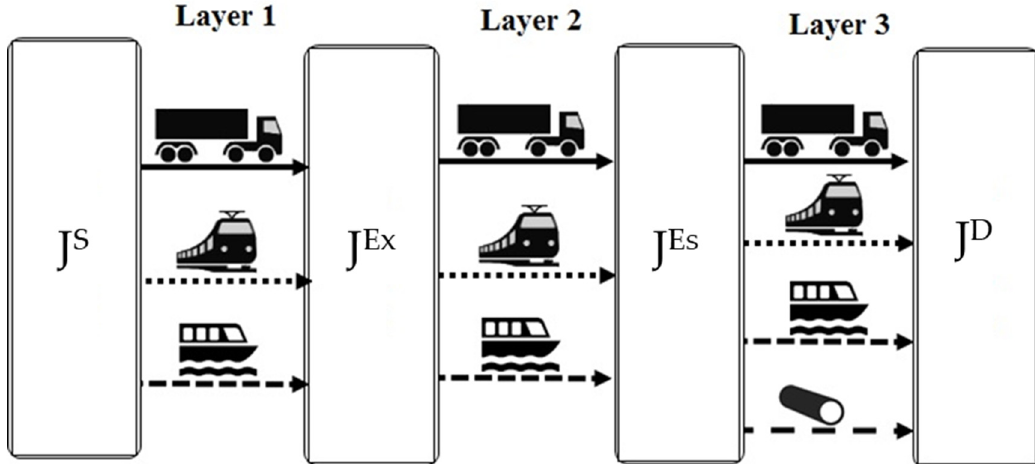
Figure 2. Schematic of the data sets included in the supply chain model. J S = Supply locations; J Ex = Extraction locations; J Es = Transesterification locations; and J D = Demand locations. The possible modes of transportation between the different locations that are considered in this work are shown and include trucks, rail, barges, and pipelines.